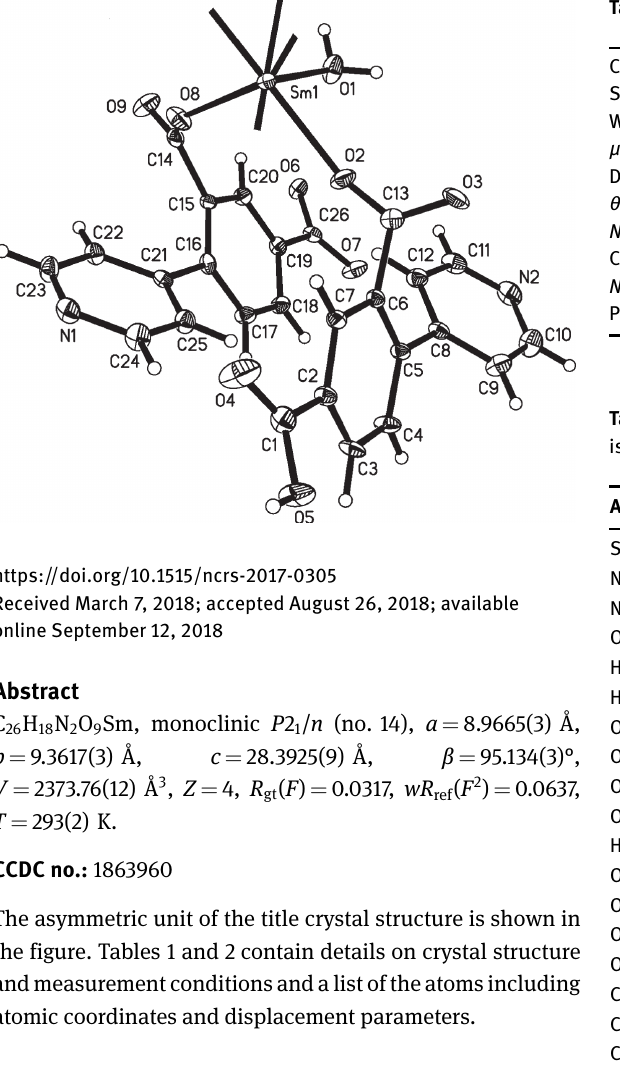
Table 1: Data collection and handling.